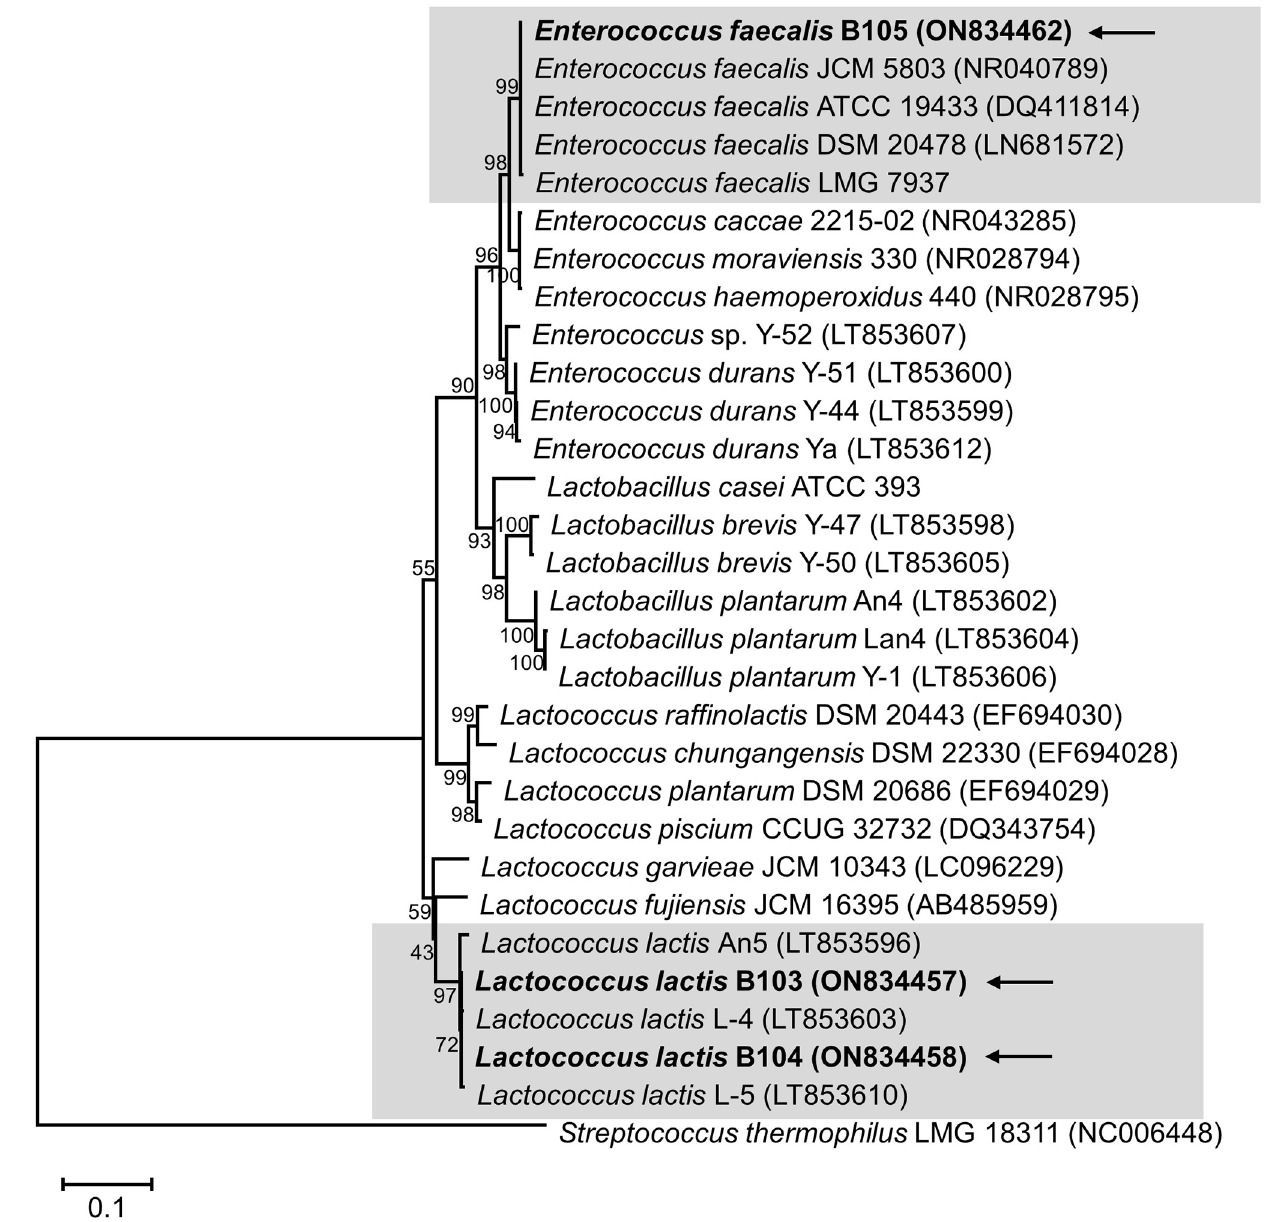
Fig 1. Phylogenetic tree of LAB based on 16S rRNA gene sequences constructed using the neighbor-joining method. The numbers above the branches are bootstrap values. Bars indicate the number of nucleotide substitutions per site. Isolates used in this study are indicated in bold and with arrows. Streptococcus thermophilus LMG 18311 (NC006448) was used as the outgroup.